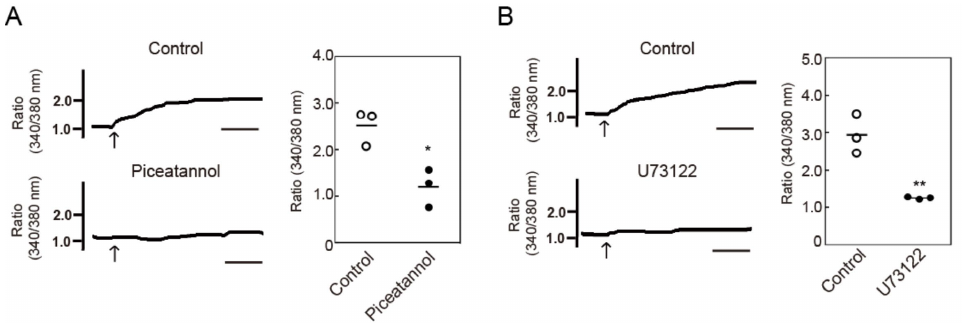
Figure 4. Effects of Syk and PLC inhibitors on MHC-II crosslinking-induced intracellular Ca 2+ mobilization. BMDCs were pre-incubated with ( A ) piceatannol (50 µM) or ( B ) U73122 (10 µM) for 30 min at 37 °C. The cytosolic Ca 2+ mobilization after MHC-II crosslinking was measured using Fura- 2/AM. Relative changes in the cytosolic Ca 2+ concentrations are expressed as the ratio of fluorescence intensity at 340/380 nm. Bars = 1 min. Values of * p < 0.05, ** p < 0.01 are regarded as significant.